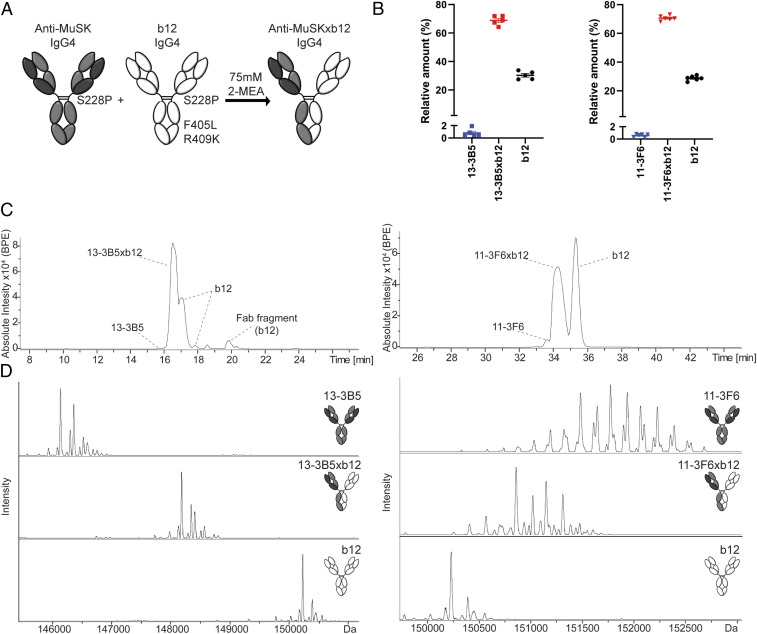
Generation of stable, MuSK MG patient-derived, bispecific, monovalent recombinant IgG4 MuSK antibodies. (A) Graphic depiction of the amino acid substitutions introduced for controlled Fab-arm exchange with IgG4. To make all antibodies resistant to Fab-arm exchange in vivo, serine 228 was converted to a proline, strengthening the interaction in the hinge region. To stabilize bispecific (monovalent) IgG4s, a leucine (L) at position 405 and a lysine (K) at position 409 were introduced in the b12 antibody to create complementary amino acids with the phenylalanine (F) and arginine (R) in the anti-MuSK IgG4s, respectively. The interaction between the heterodimers is stronger than that between the homodimers, preventing in vivo and further in vitro exchange of the bispecific IgG4. (B) The exchange reaction with 75 mM 2-mercaptoethylamine (2-MEA) yielded high exchange efficiency with <1% contamination of the original monospecific (bivalent) anti-MuSK IgG4 for both clones (n = 5). The b12 exchange partner was added in excess, yielding a remnant of ∼30% after exchange. Representative examples of (C) base peak electropherogram (BPE) and (D) deconvoluted mass spectra of 11–3F6 and 13–3B5, respectively. The materials for 11–3F6xb12 exchange efficiency tests came from productions in both CHO and HEK293 cells. Representative images of 11–3F6 and 11–3F6xb12 deconvoluted mass spectra are from a production in CHO cells. Data represent mean ± SEM.